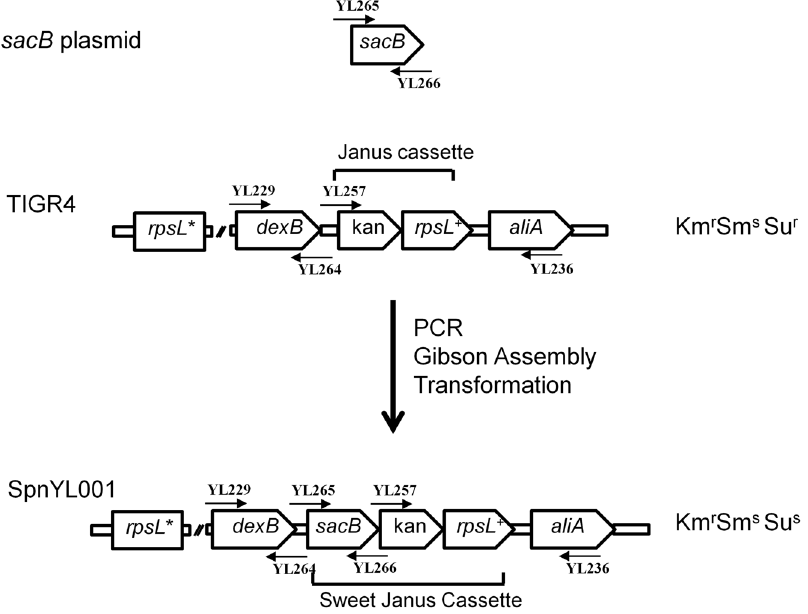
Figure 1. Construction of Sweet Janus (SJ) cassette in the cps locus of pneumococcus. Pentagons represent cassette elements and the dexB and aliA genes flanking the cps locus. Arrows represent oligonucleotides used to amplify fragments of the SJ cassette by PCR (see Table 1 for primer sequences). rpsL * represents the Sm r mutant rpsL copy in the genomic region outside the Janus or SJ cassette. The PCR products were assembled into the SJ by using Gibson Assembly and the SJ was used to transform the TIGR4S strain to construct the SpnYL001